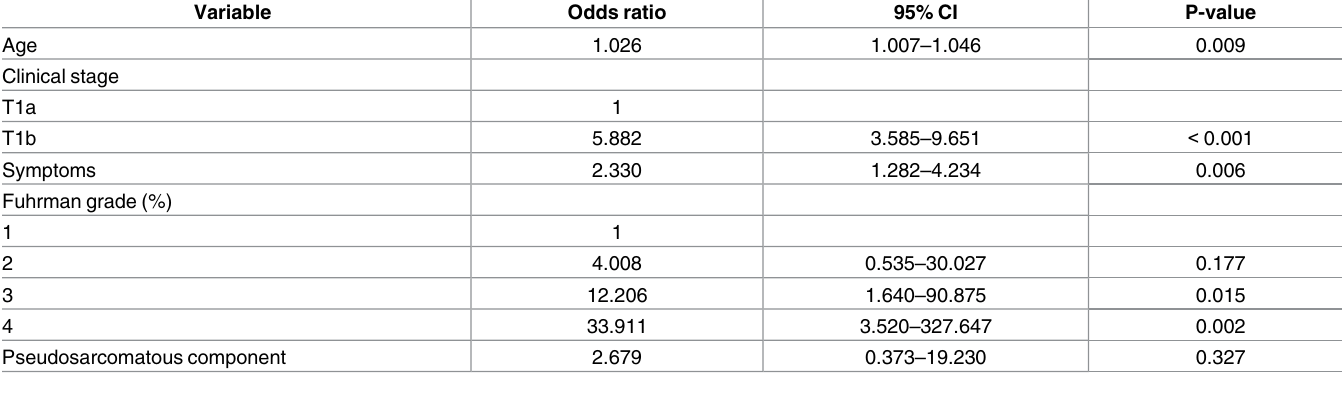
Table 2. Multivariate analysesof clinicopathological parametersthat were associated with pT3a upstaging.